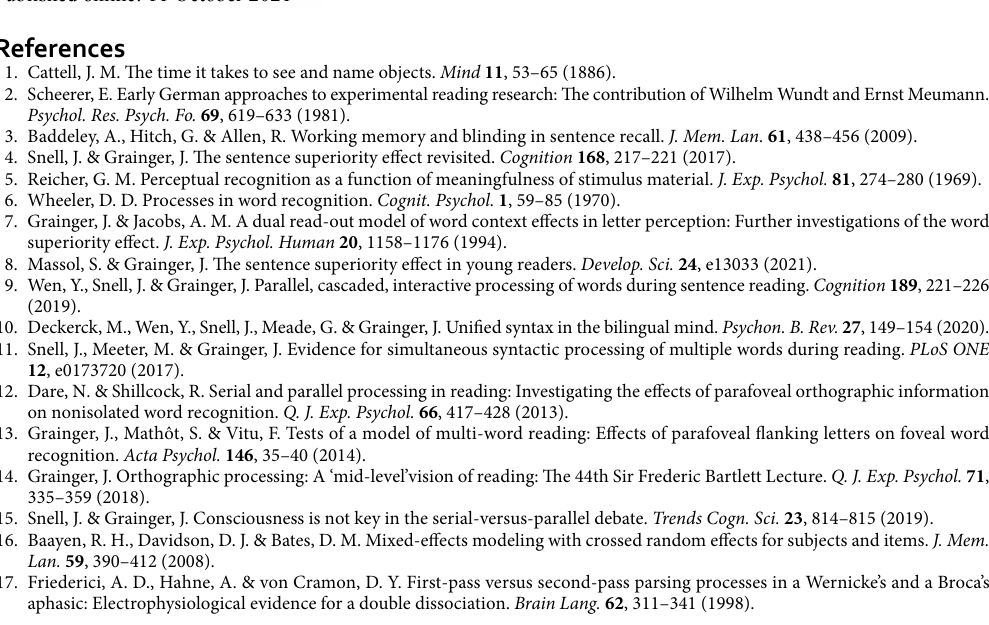
order. The experiment lasted approximately 25 min.